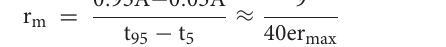
R 2 = 0.92, R 2 = 0.82, R 2 = 0.76 for the young, middle, near-mature, mature, and over-mature stands, respectively. Furthermore, all the parameters were significant at the level of 0.05 ( Table 2 ). All trees in different age classes showed the similar trend of wood cell development but with a different timing of the inflection point and different number of cells ( Table 3 ). A bimodal pattern was detected in number of cambial cells and number of enlarging cells ( Figures 1A,B ). A bell-shaped curve was found in the number of wall-thickening ( Figure 1C ). The dynamics of the number of mature cells and total number of cells was S-shape ( Figures 1D,E